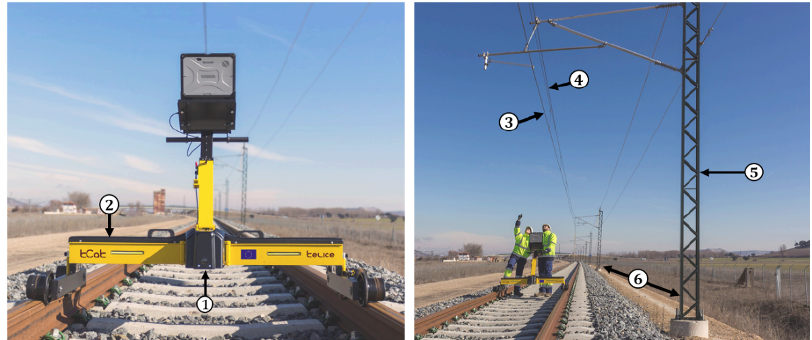
Figure 3. System used to perform the point clouds recording (Telice) in a typical railway environment where its key points; LiDAR (1), trolley (2), contact wire (3), messenger wire (4), mast (5) and mid-span (6) can be